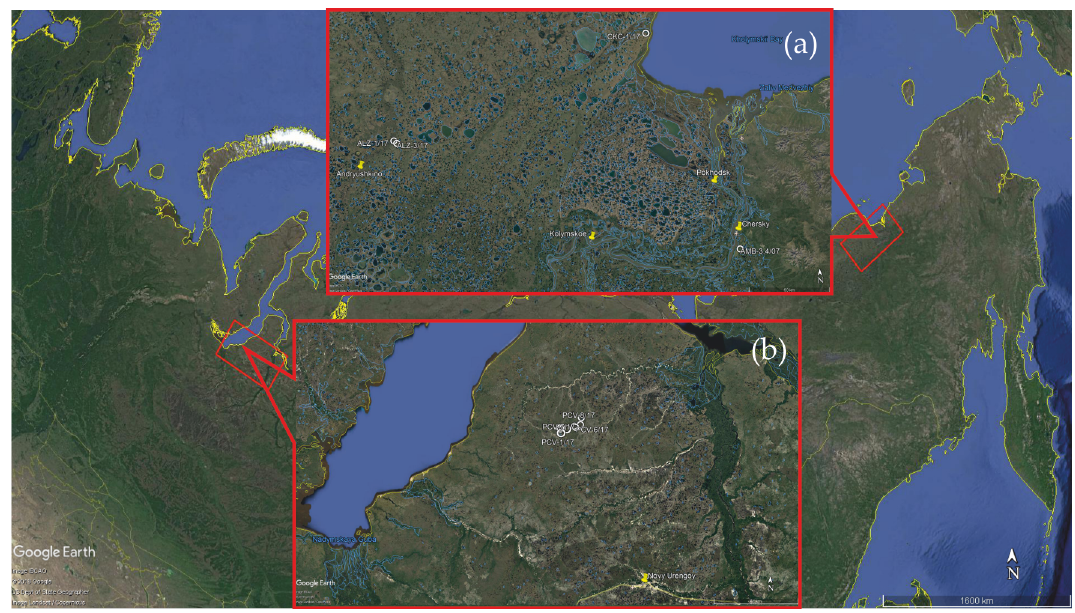
Figure 1. Location of study sites and boreholes in ( a ) the Kolyma Lowland, northeastern Siberia; ( b ) the Pur Lowland, West